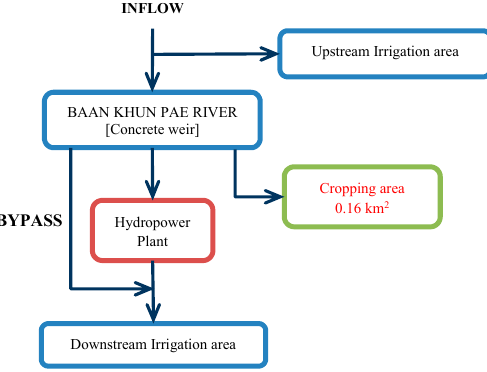
Figure 4. Assumption of water use in the Baan Khun Pae Basin.